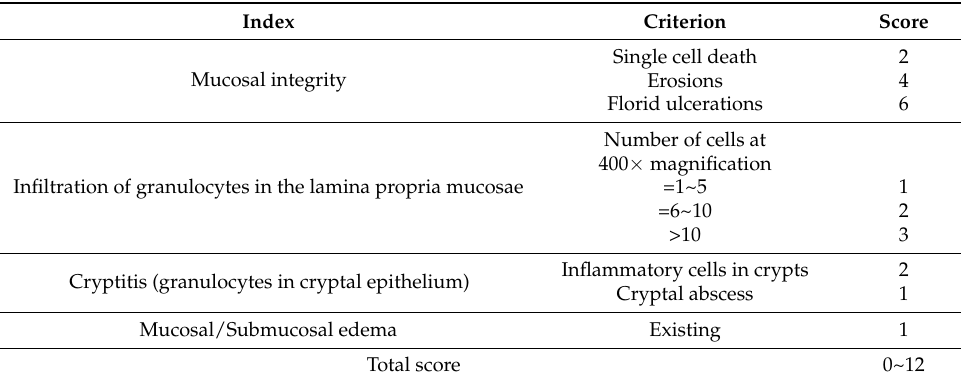
Table 2. Indices, criteria and scores for histological scoring.